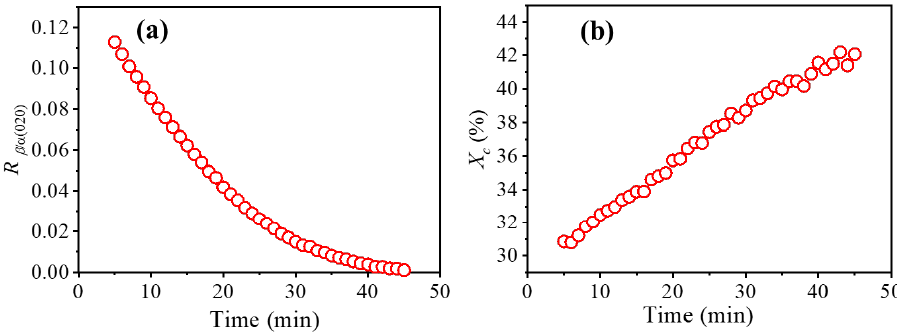
Figure 4. ( a ) R β /(020) and ( b ) X c of two-step-drawn PHBV films during annealing at 130 °C.